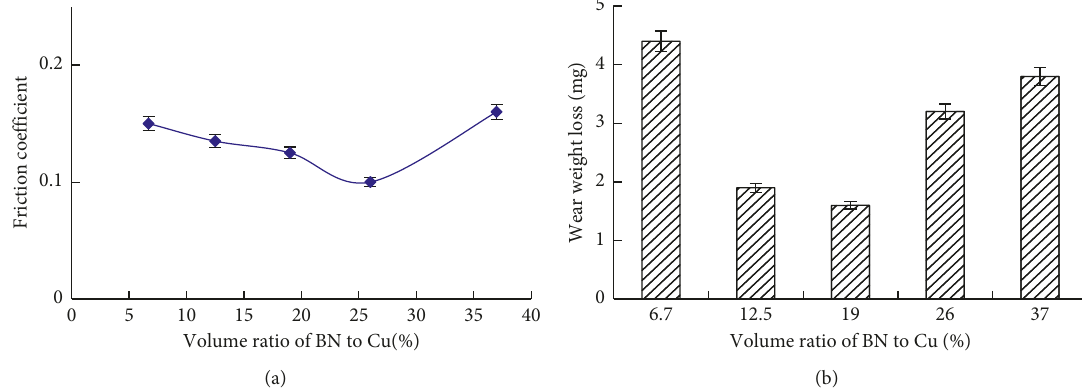
Figure 12: Effect of the volume ratio of h-BN to Cu on (a) friction coefficient and (b) wear weight loss (capacitance is the 3rd grade).